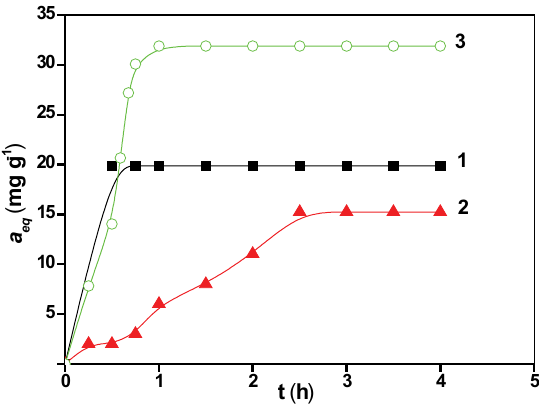
Figure 3. Effect of agitation time on the adsorption of mercury(II) ions by silica adsorbents 1–3 (curves 1–3 respectively); 0.01 M aqueous solution of Hg(NO